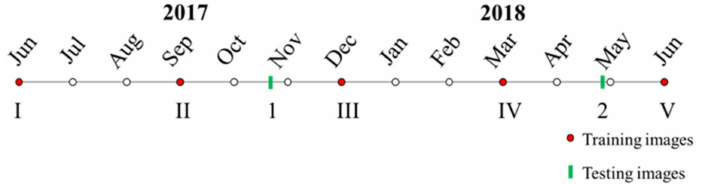
Figure 3. Temporal distribution of training and testing images along the LEM dataset.